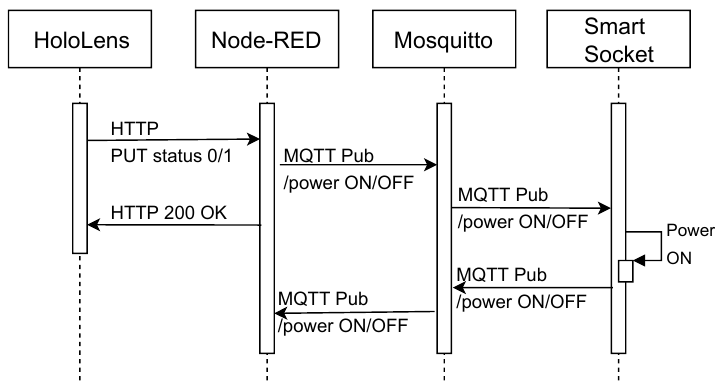
Figure 9. Sequence diagram for the switching ON/OFF of the smart socket.